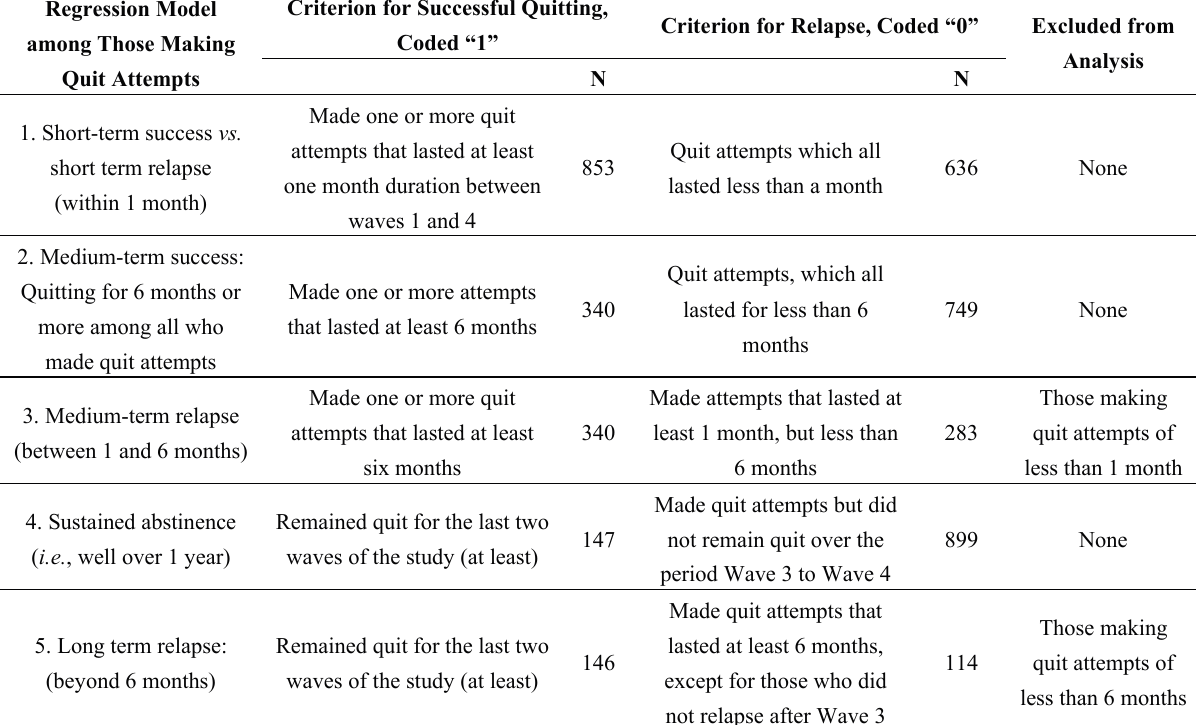
Table 1. Summary of the five sets of regressions on predictors of quit success relapse among those making quit attempts over the period of the